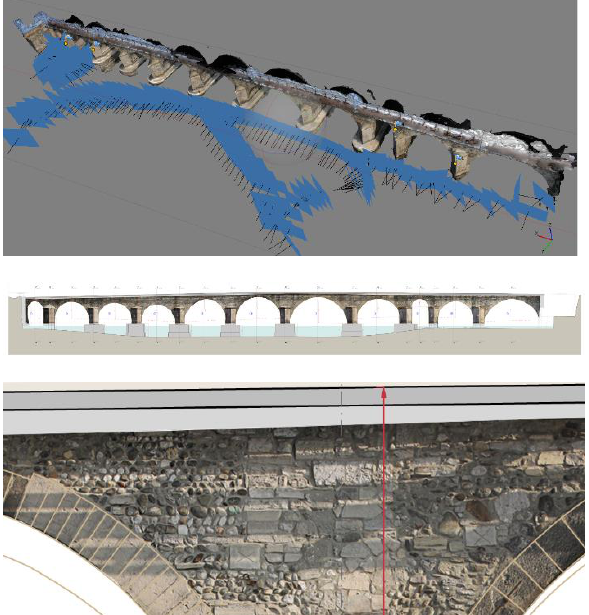
Figure 3. Some of the images (top) of the bridge acquired from a boat and then used to create digital orthophotos